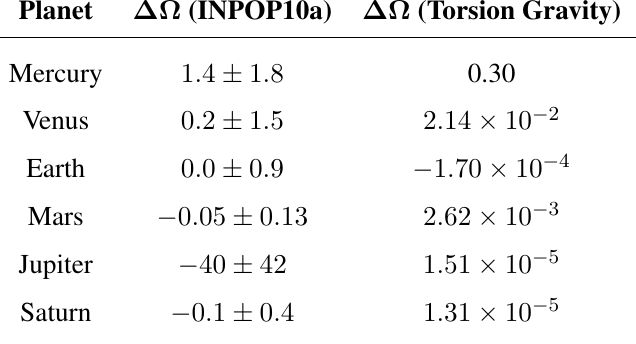
Table 1. Corrections to the secular node precessions as obtained in the INPOP10a ephemeris and predictions of the torsion gravity model discussed in this paper in milliarcseconds per